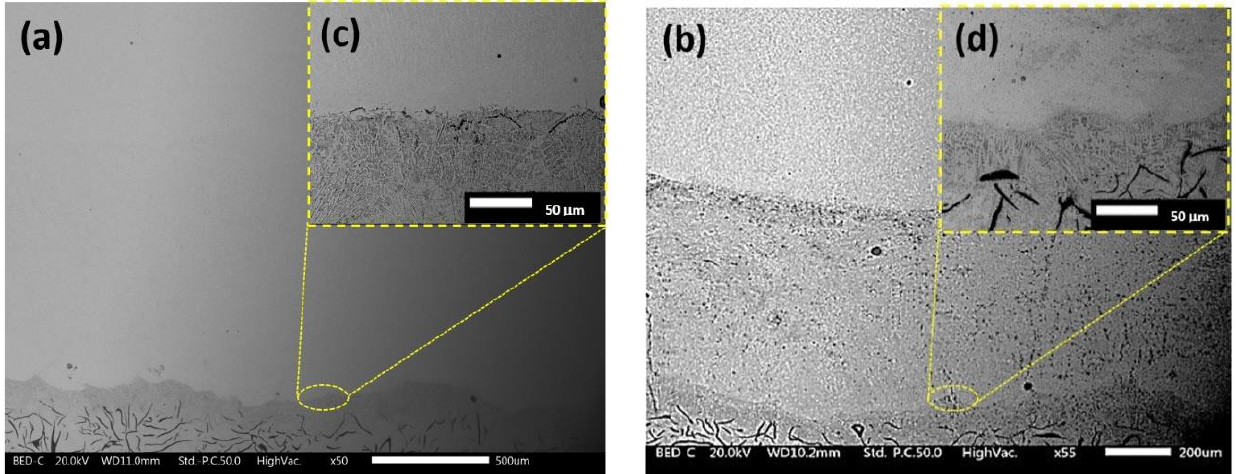
Figure 2. Cross-section view of the coated disc: ( a ) without buffer layer, and ( b ) with buffer layer; ( c ) higher magnification of the interface without a buffer layer; ( d ) higher magnification of the interface with a buffer layer.